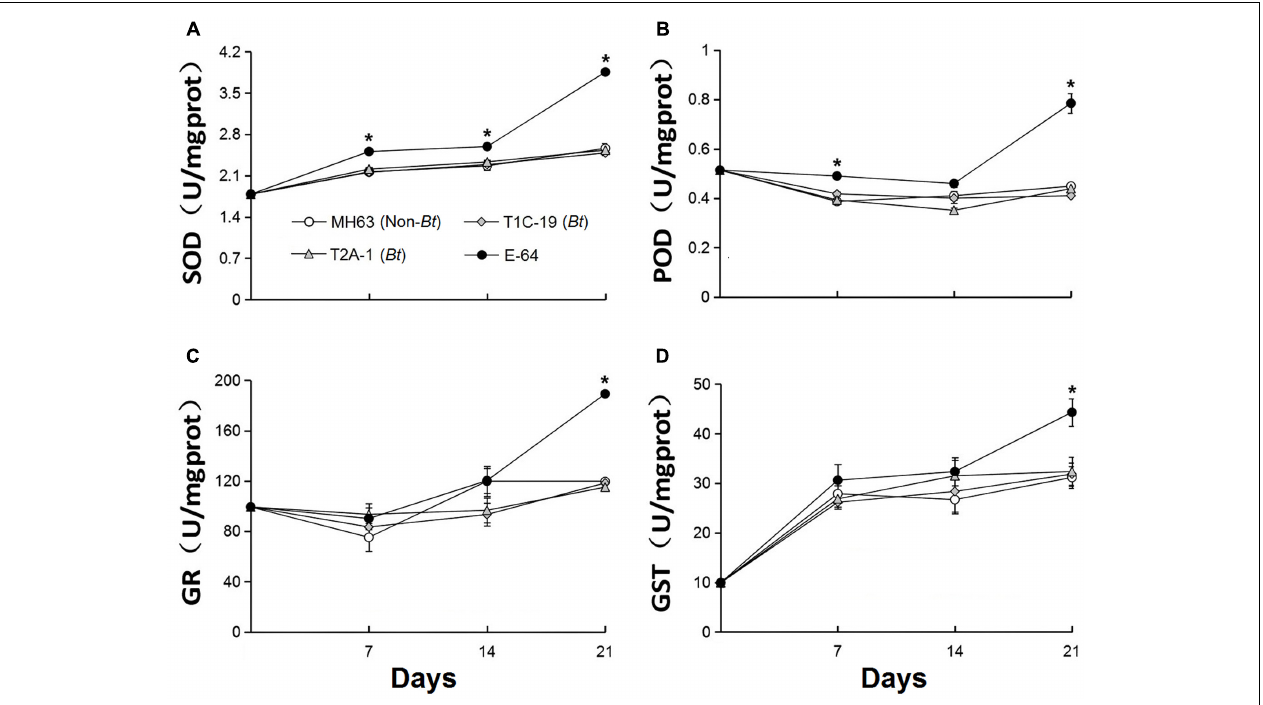
FIGURE 4 | Enzyme activities ( A : POD, B : SOD, C : GR, and D : GST) in F. candida that fed on non- Bt rice leaves (MH63, negative control), Bt rice leaves containing Cry1C or Cry2A (T1C-19 or T2A-1), or non- Bt leaves containing E-64 protein (E-64, positive control) for 35 days. Rice leaf powder was mixed with baker’s yeast (10:1). Values are means ± SE, n = 4. Asterisks indicate a significant difference between the treatment and the negative control (MH63) ( P <